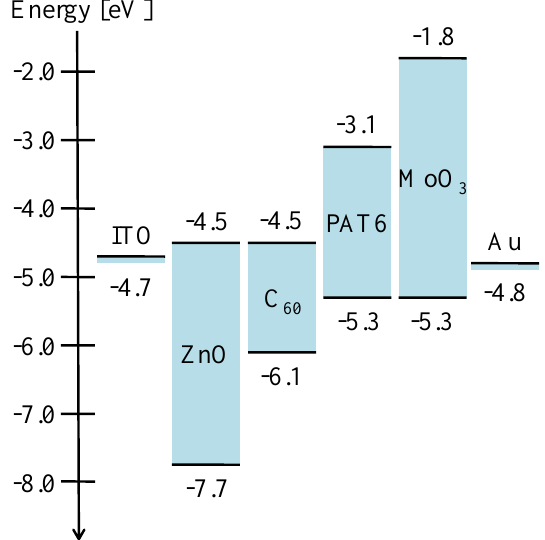
, PAT6, MoO , and 60 3